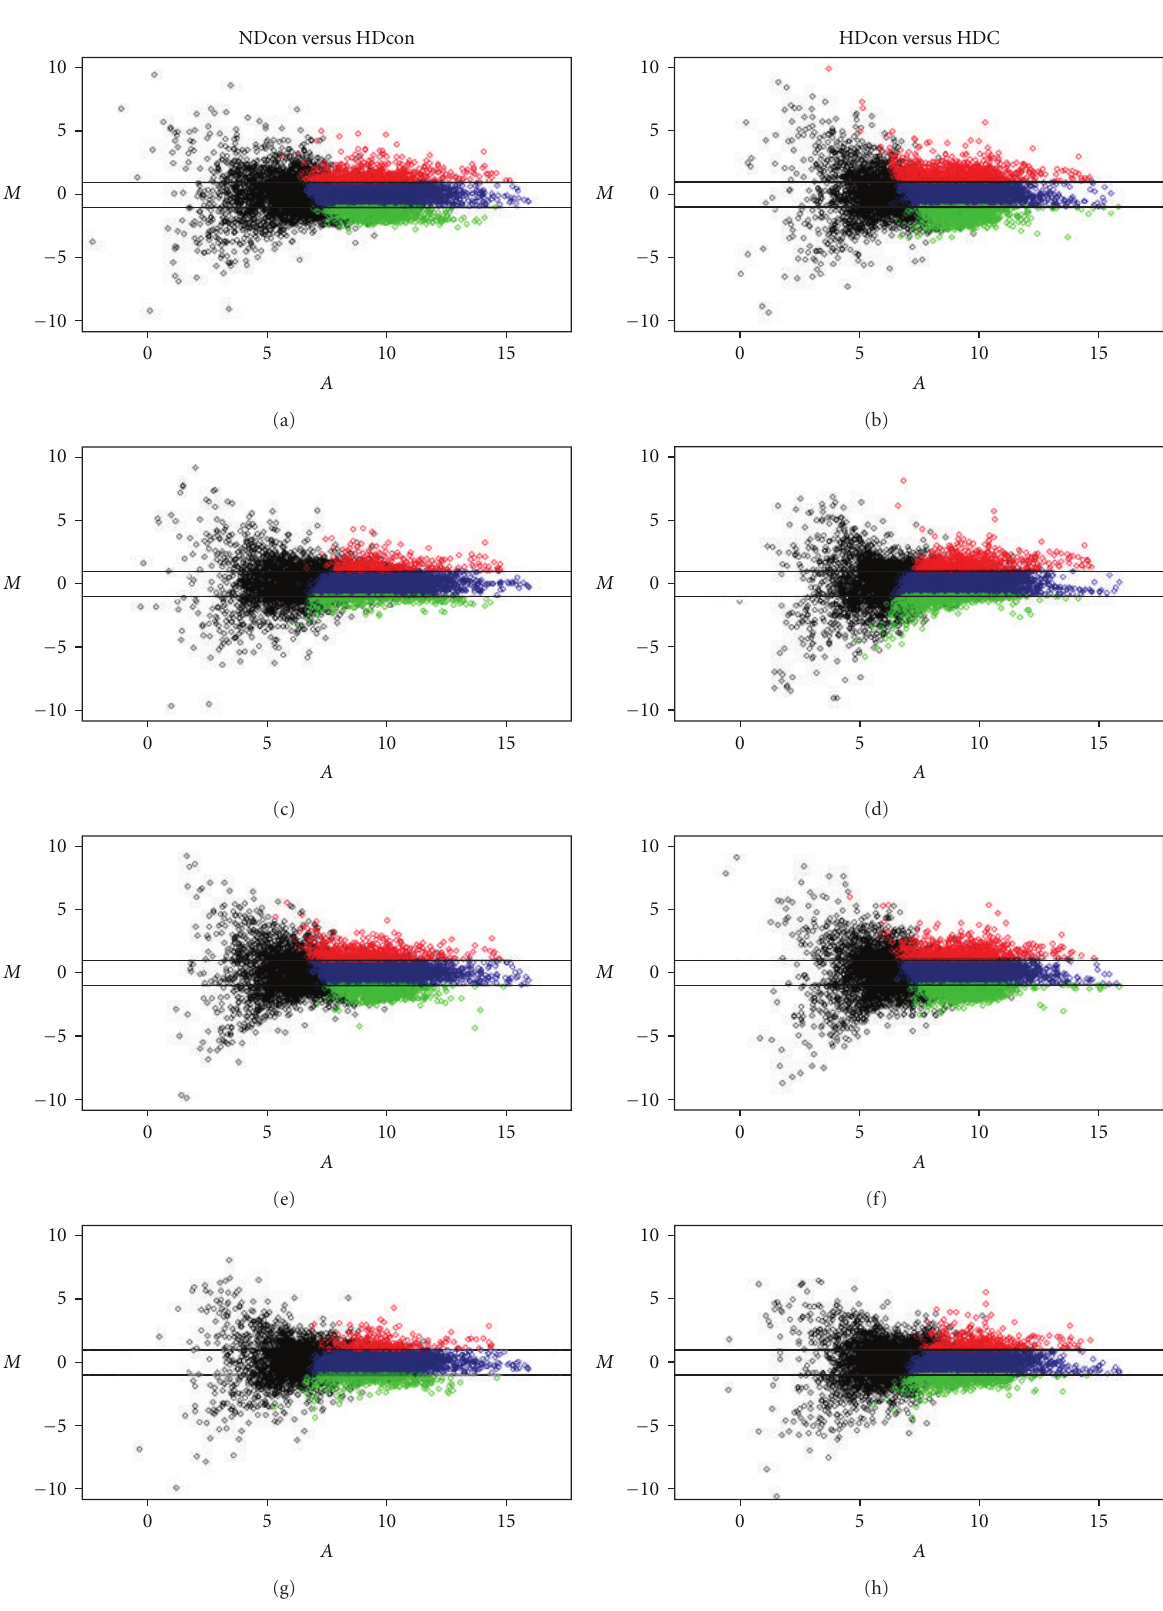
Figure 2: Representative MA plots comparing the NDcon versus the HDcon groups and the HDcon versus the HDC groups. M represents the log ratio of the average intensities at two fluorescent dyes used to label probes, and A represents averaged logarithmic intensity. Broken lines represent a 2-fold